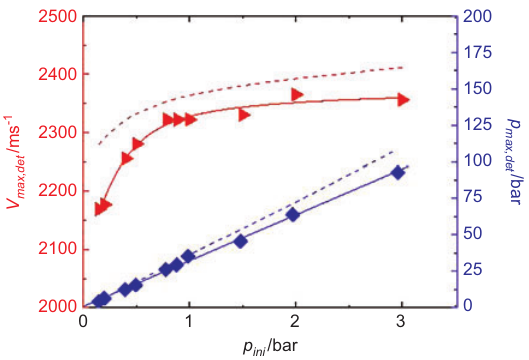
Figure 11 Dependence of detonation velocity and detonation pressure on initial pressure compared with theoretical values for stoichio metric (equivalence ratio = 1) propane/O mixtures. 2 detonation velocity, experimental; detonation velocity, calculated; detonation pressure, experimental; detonation pressure,